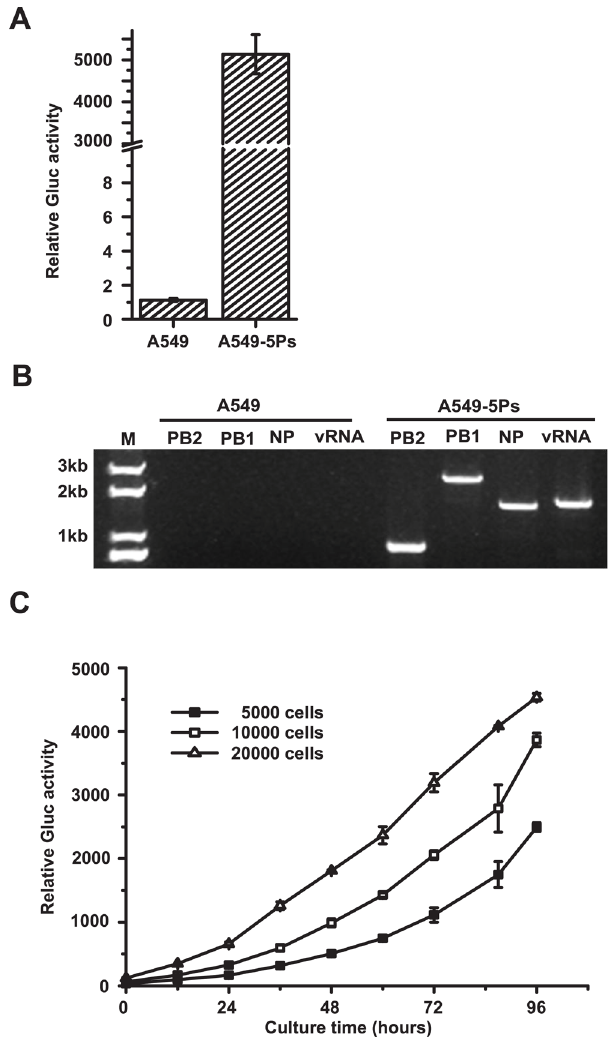
Fig 2. Characterization of A549-5Ps cells. (A-B) Stable expression of influenza A virus minigenome transcription/replication system in A549-5Ps cells. A549 and A549-5Ps cells were seeded in 6-well plates and cultured for 48 hours. (A) Gluc activity in supernatants was quantified. (B) Total cellular RNAs were extracted and then subjected to RT-PCR using primer pairs specific for PB2, PB1, NP and model vRNA. (C) Relative Gluc activity over a 96-hour time course at different A549-5Ps cell numbers. A549 and A549-5Ps cells were seeded in 96-well plates (5,000/well, 10,000/well, 20,000/well) and supernatants were harvested at different time points, followed by Gluc activity measurement. Error bars standard error of the mean of three independent